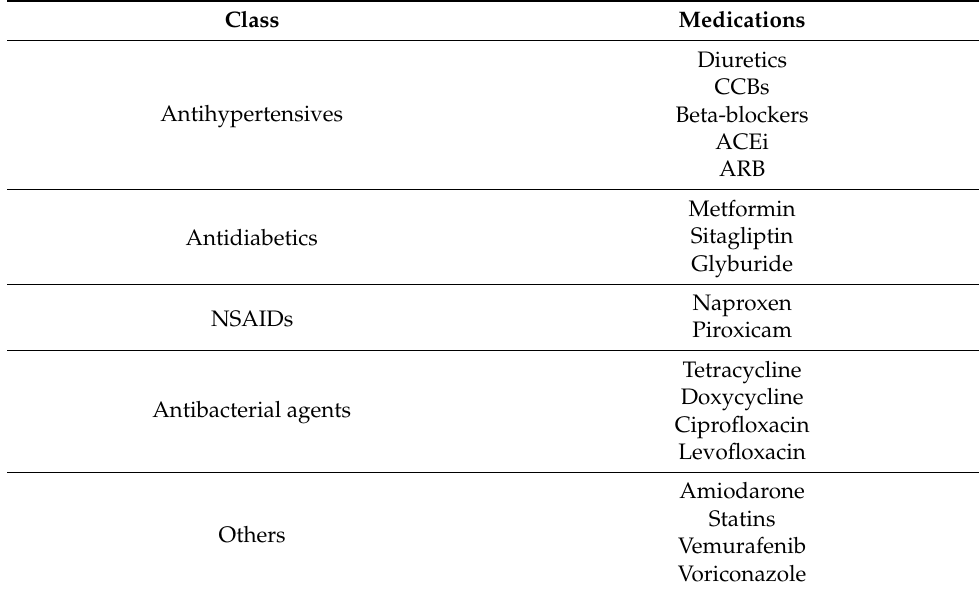
Table 1. Common photosensitizing